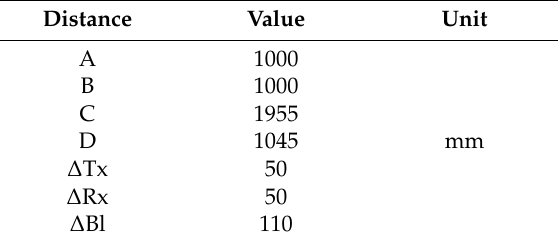
Table 3. First test distances.